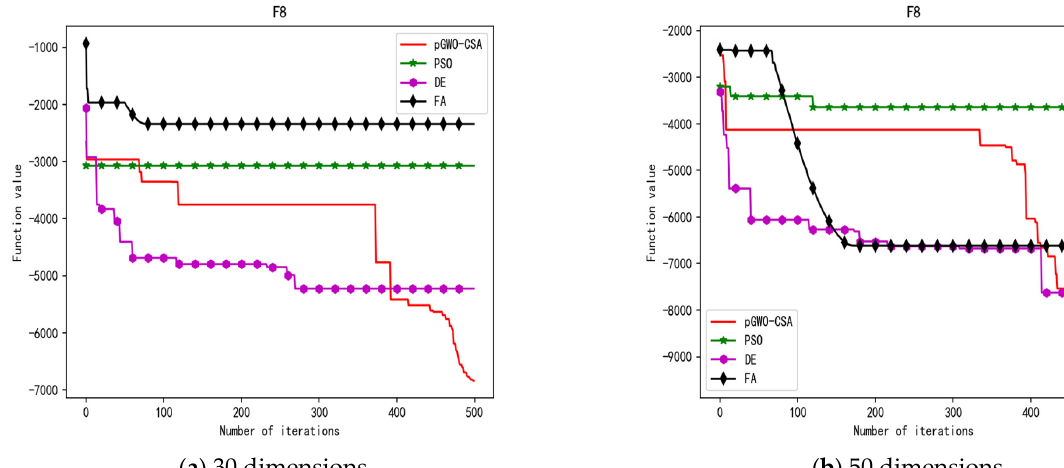
Figure 11. Convergence curve of test function F7.